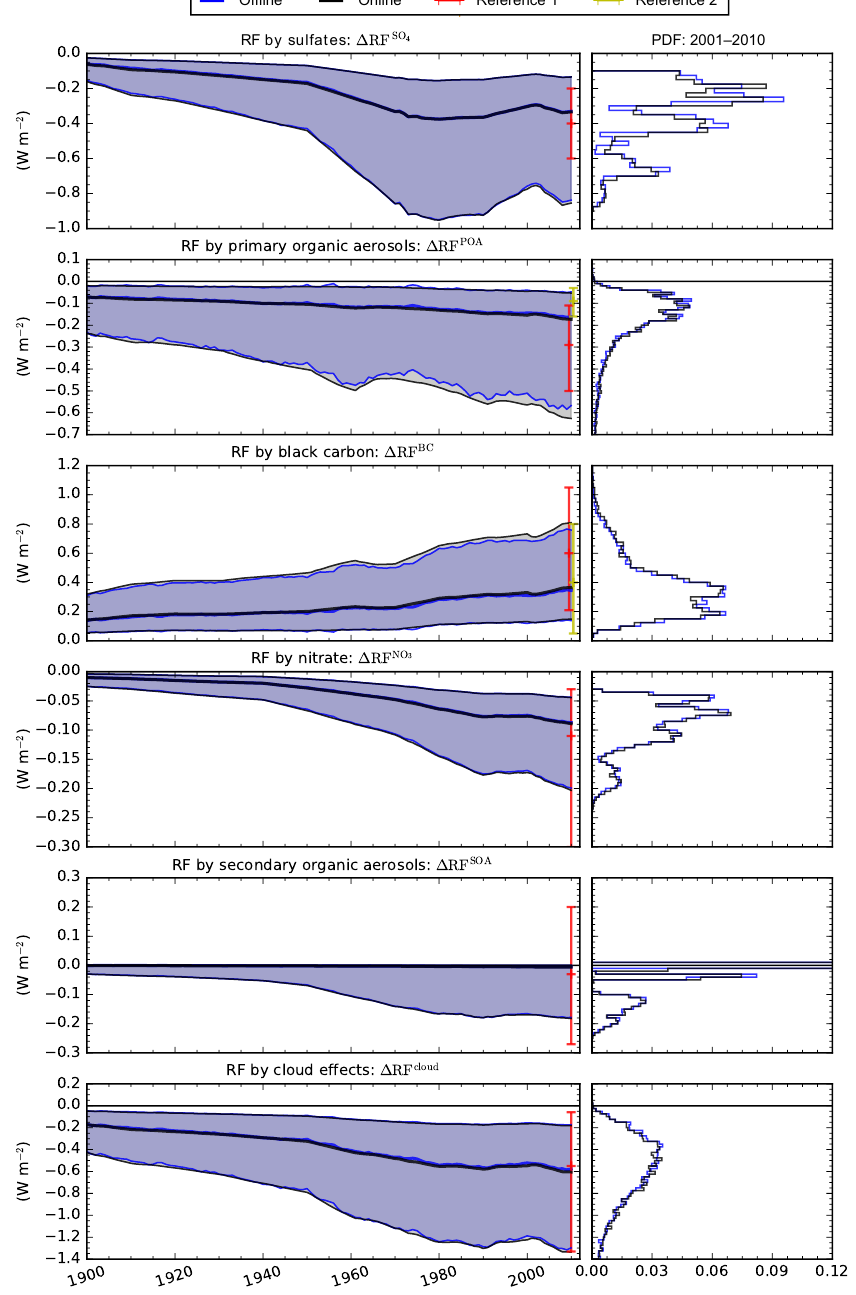
Figure 10. Results of our simulations with OSCAR, for aerosols, with the same format as for carbon dioxide. Reference 1 for the radiative forcing and its 90% uncertainty range is IPCC (Myhre et al., 2013b). Reference 2 is the same except that contribution from biomass burning aerosols is